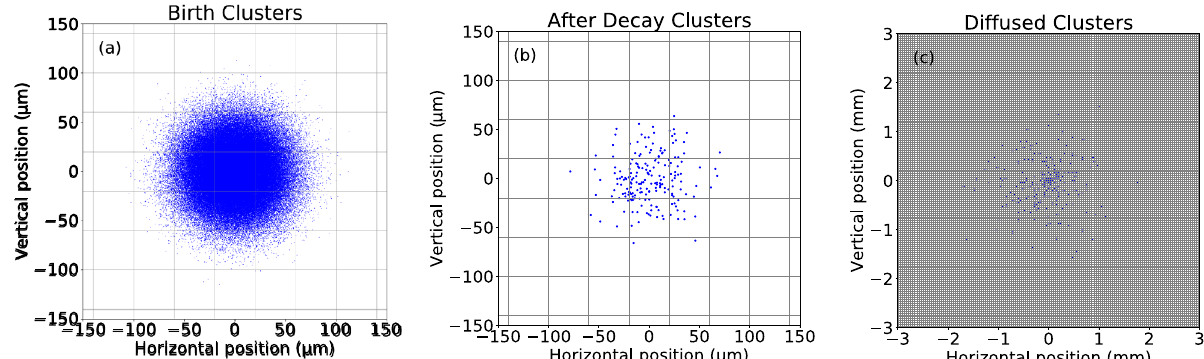
Figure 1. Simulated images of excimer clusters illustrating clusters ( a ) immediately after formation confined to the mean free path of ionizing radiation ( b ) immediately after annihilation of many excimers due to Penning ionization and ( c ) diffusion of excimers after ~ 11 s. The grid represents a camera pixel of 40 µm by 40